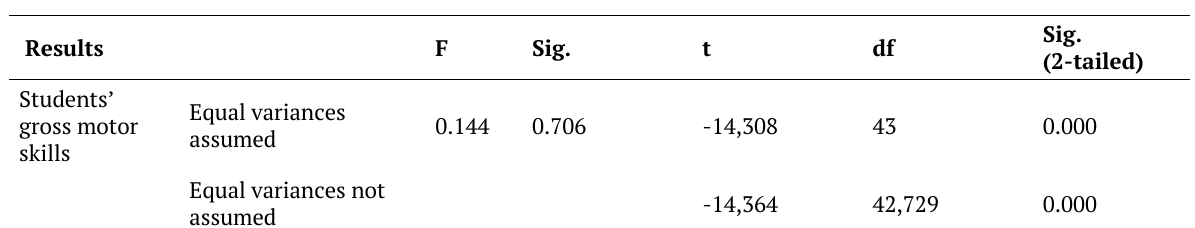
Table 4. Independent Samples Test